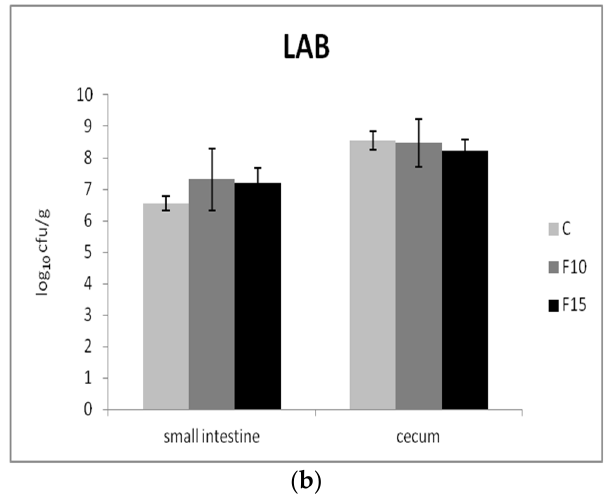
Figure 6. Effect of application of fermented feed on ( a ) enterobacteria (ENT) and ( b ) lactic acid bacteria (LAB) in the contents of the small intestine and cecum (n = 10). Means with different superscripts are significantly different ac p < 0.01.